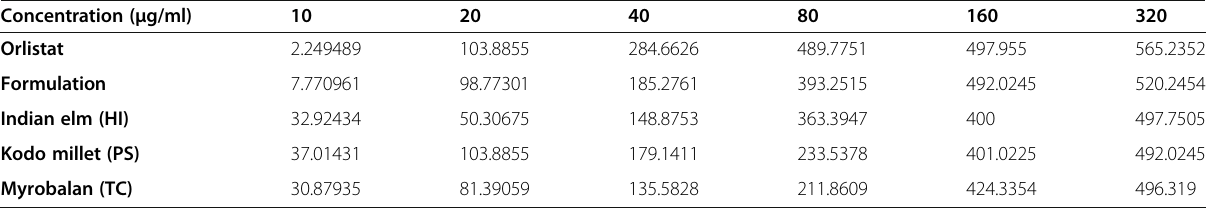
Table 5 In vitro lipase activity